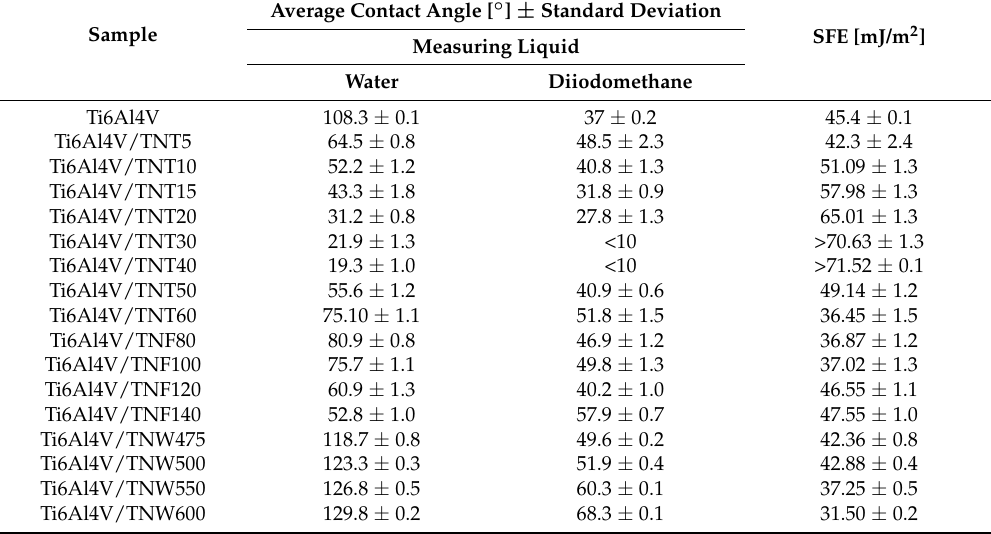
Table 1. Results of the contact angle and surface free energy (SFE) measurements; contact angles were measured three times using distilled water and diiodomethane, and the SFE was determined using the Owens–Wendt method.